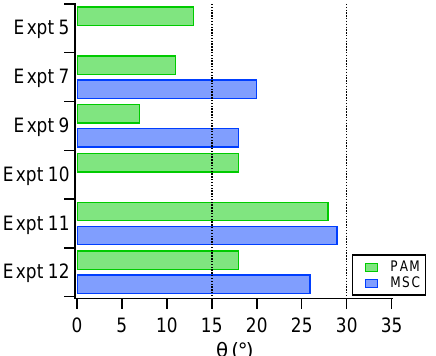
Figure 8. Comparison of PAM and MSC mass spectra to SC mass spectra for SOA generated during each wood-combustion experi- ment when OH exposures were within 30% (Table 1). Theta ( θ) , the angle between two mass spectral vectors, describes the degree of similarity between the two mass spectra (Kostenidou et al., 2009). Dashed vertical lines indicate θ of 15 and 30 ◦ . Values of θ less than 15 ◦ indicate good agreement between the mass spectra, values between 15 and 30 ◦ indicate that there are similarities, but also im- portant differences, and values greater than 30 ◦ indicate poor agree- ment (Bougiatioti et al.,